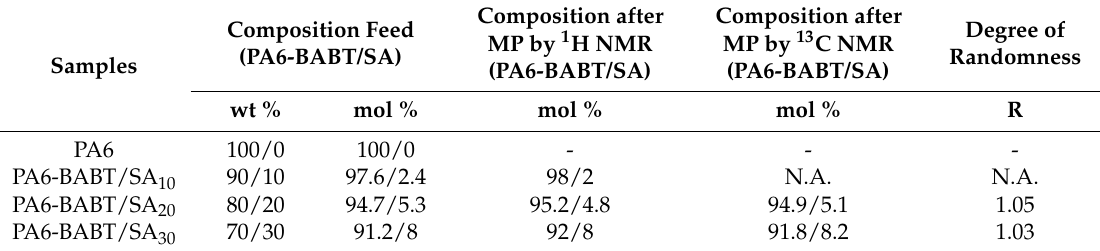
Figure 8. ( A ) 13 C NMR Expanded spectra of BABT-SA, PA6, and PA6-BABT/SA 30 recorded in TFAA solvent. ( B ) Assignment of the carbonyl resonances (marked with an asterisk) in the PA6-BABT/SA copolyamides for possible dyad sequences. Table 2. Composition and degree of randomness of the PA6-BABT/SA copolymers prepared by melt condensation reaction.